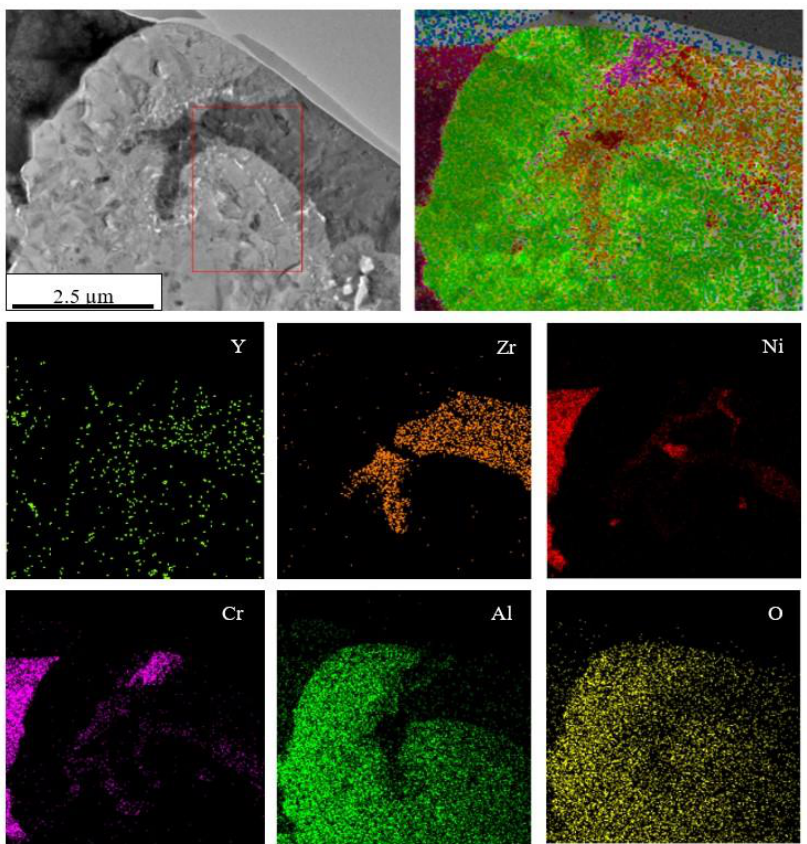
Figure 11 . Cross-sectional microstructure and the corresponding EDS mapping of sample, H100h.